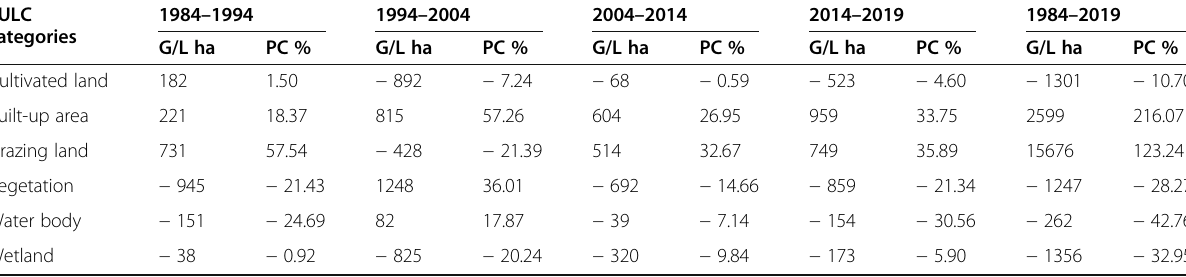
Table 6 The land use/land cover (LULC) changes (gain, loss, and rate of change) between 1984 and 1994, 2004 and 2014, and 2014 and 2019, where G=gain, L=loss and PC= rate of